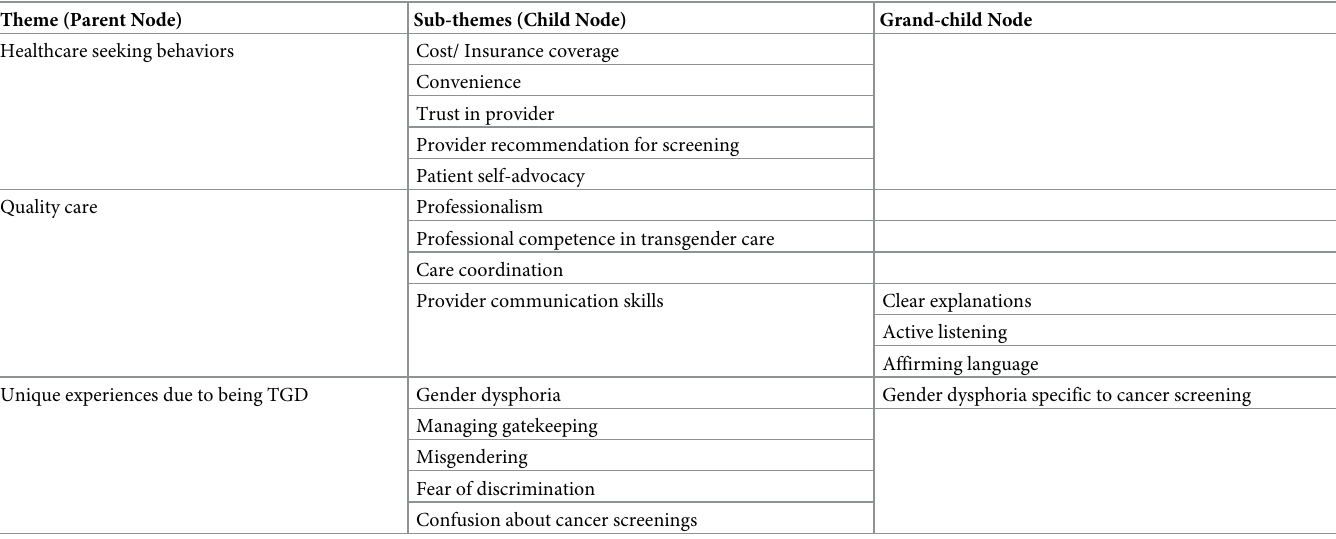
Table 2. Major themes and